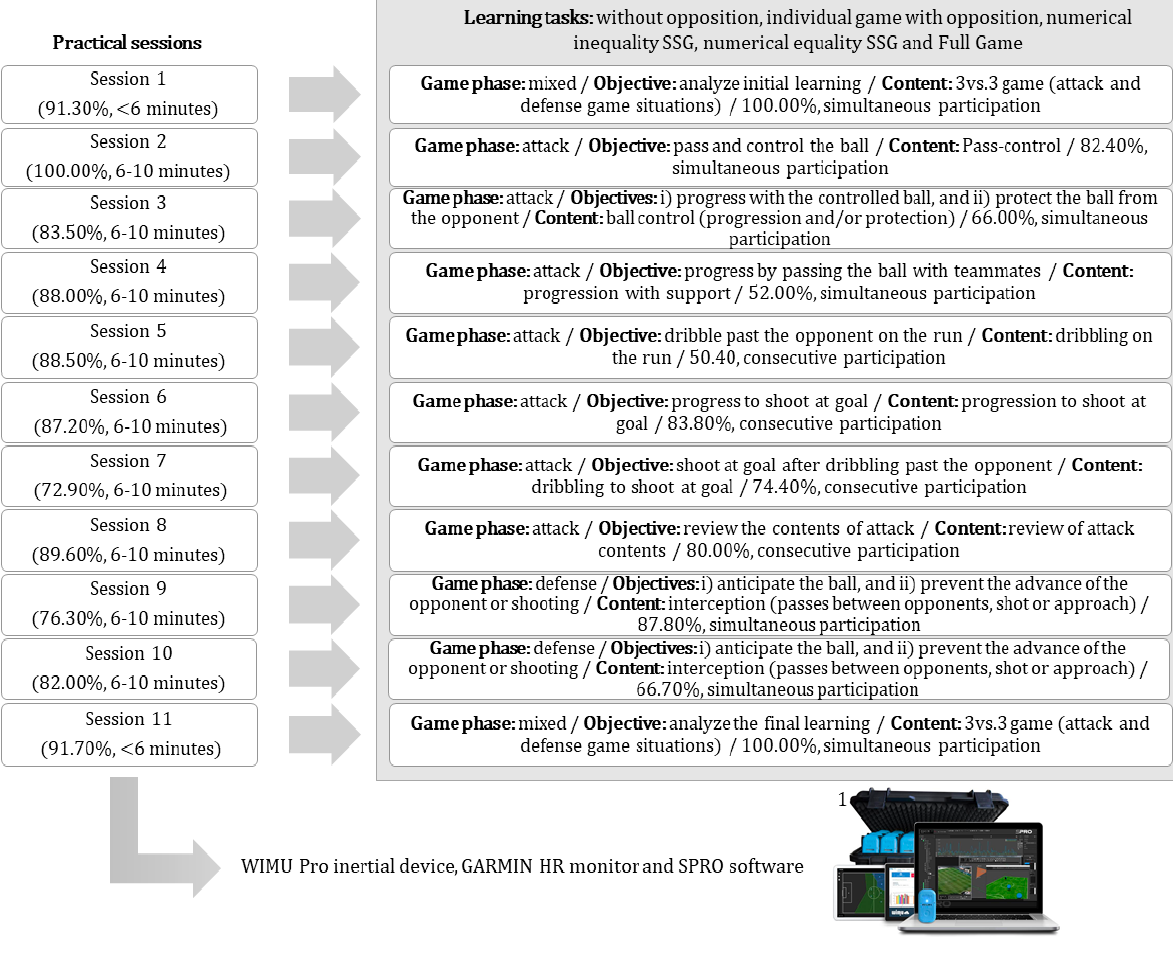
Figure 1. Attack and defense contents developed in practical sessions. Note: SSG = Small-Sided Games. 1 RealTrack System, Almería, Spain. The percentage on the left refers to the total time of the task, while the percentage on the right refers to the type of participation and indicates the most used category in each variable.